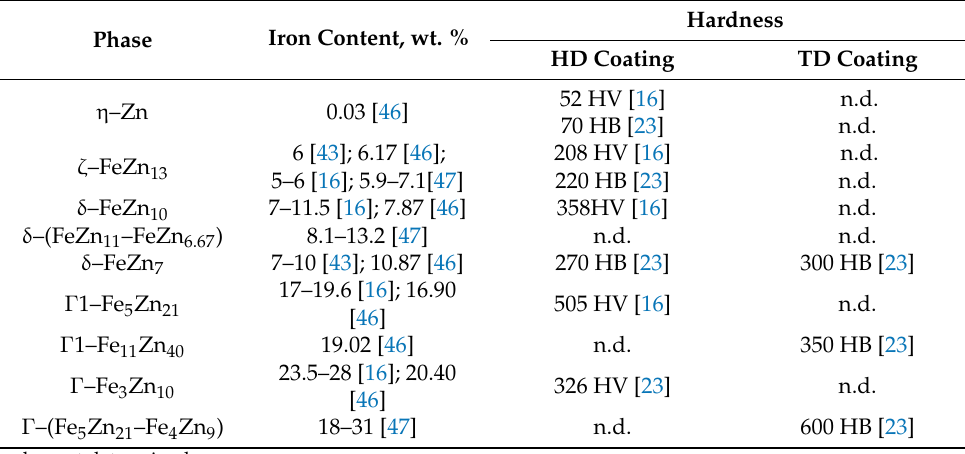
Table 1. Chemical formula and hardness of Fe-Zn intermetallic phases. Phase Iron Content, wt.